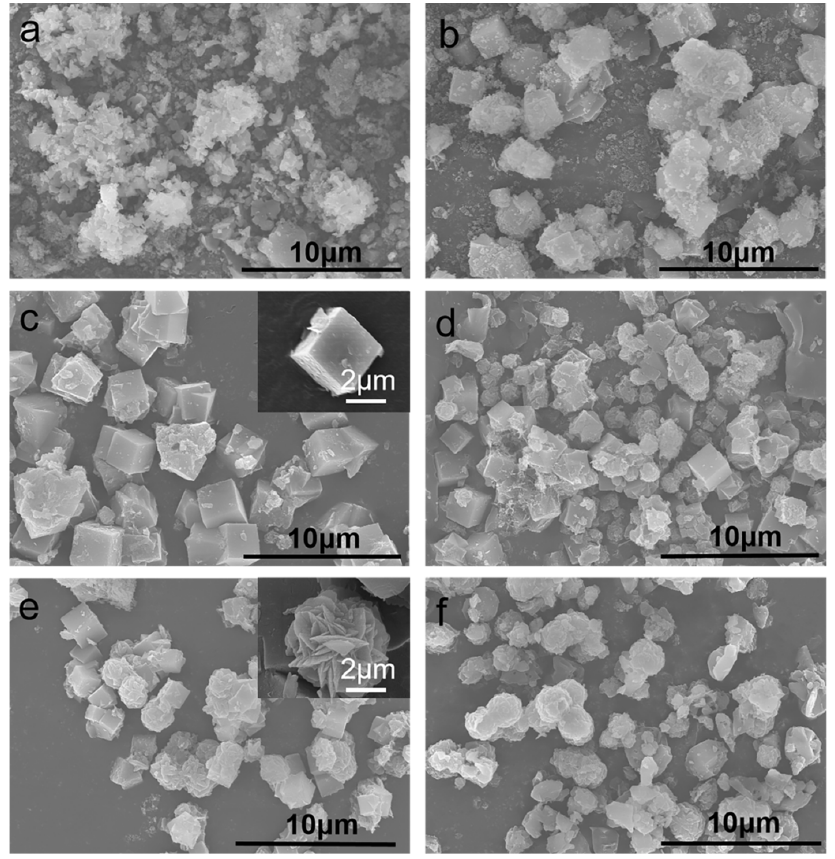
Figure 5. SEM images of samples synthesized at different NaOH concentrations (NaOH concentra- tions: ( a ) 0.25 mol·L − 1 , ( b ) 0.5 mol·L − 1 , ( c ) 1.0 mol·L − 1 , ( d ) 1.5 mol·L − 1 , ( e ) 2.0 mol·L − 1 and ( f ) 2.5 mol·L − 1 ). trations: ( a ) 0.25 mol · L − 1 , ( b ) 0.5 mol · L − 1 , ( c ) 1.0 mol · L − 1 , ( d ) 1.5 mol · L − 1 , ( e ) 2.0 mol · L − 1 and ( f ) 2.5 mol · L − 1